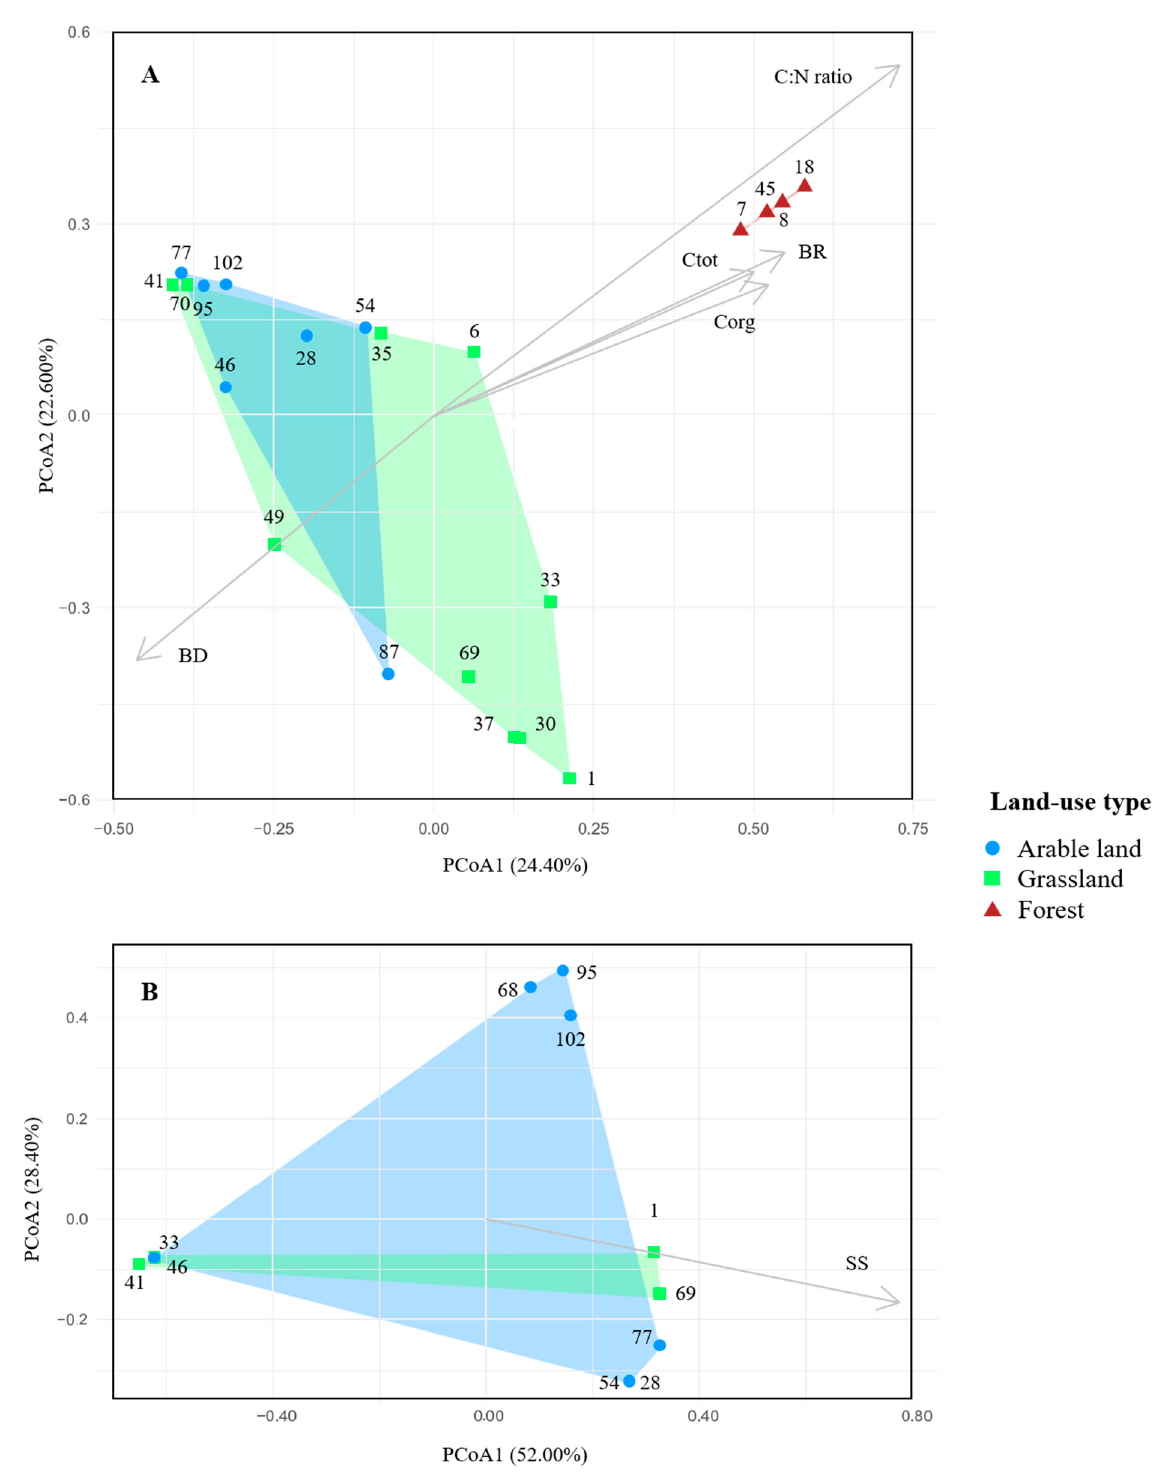
Figure 4. Principal coordinate analysis (PCoA) based on a Bray–Curtis dissimilarity matrix showing differences between ( A ) M. brunneum and ( B ) M. robertsii populations at the sites of three land-use types: arable land, grassland, and forest. Circles (arable land), squares (grassland), and triangles (forest) represent M. brunneum or M. robertsii populations at the different sites (site numbers indicated). Convex hulls enclose samples of the same land-use type. The percentage of variation explained by the plotted principal coordinates is indicated on the axes. Vectors represent the best fitted and explained environmental factors, and vector lengths represent the strength of correlation. C:N ratio: ratio of organic carbon and total nitrogen; Ctot: total carbon; Corg: organic carbon; BR: basal respiration; BD: bulk density; SS: soil